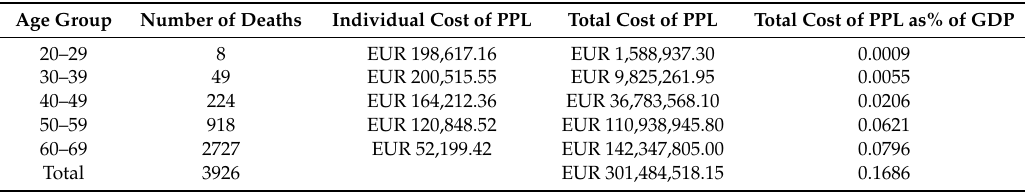
Table 3. Estimated permanent productivity loss per age groups calculated with the HCA (2020 euros).